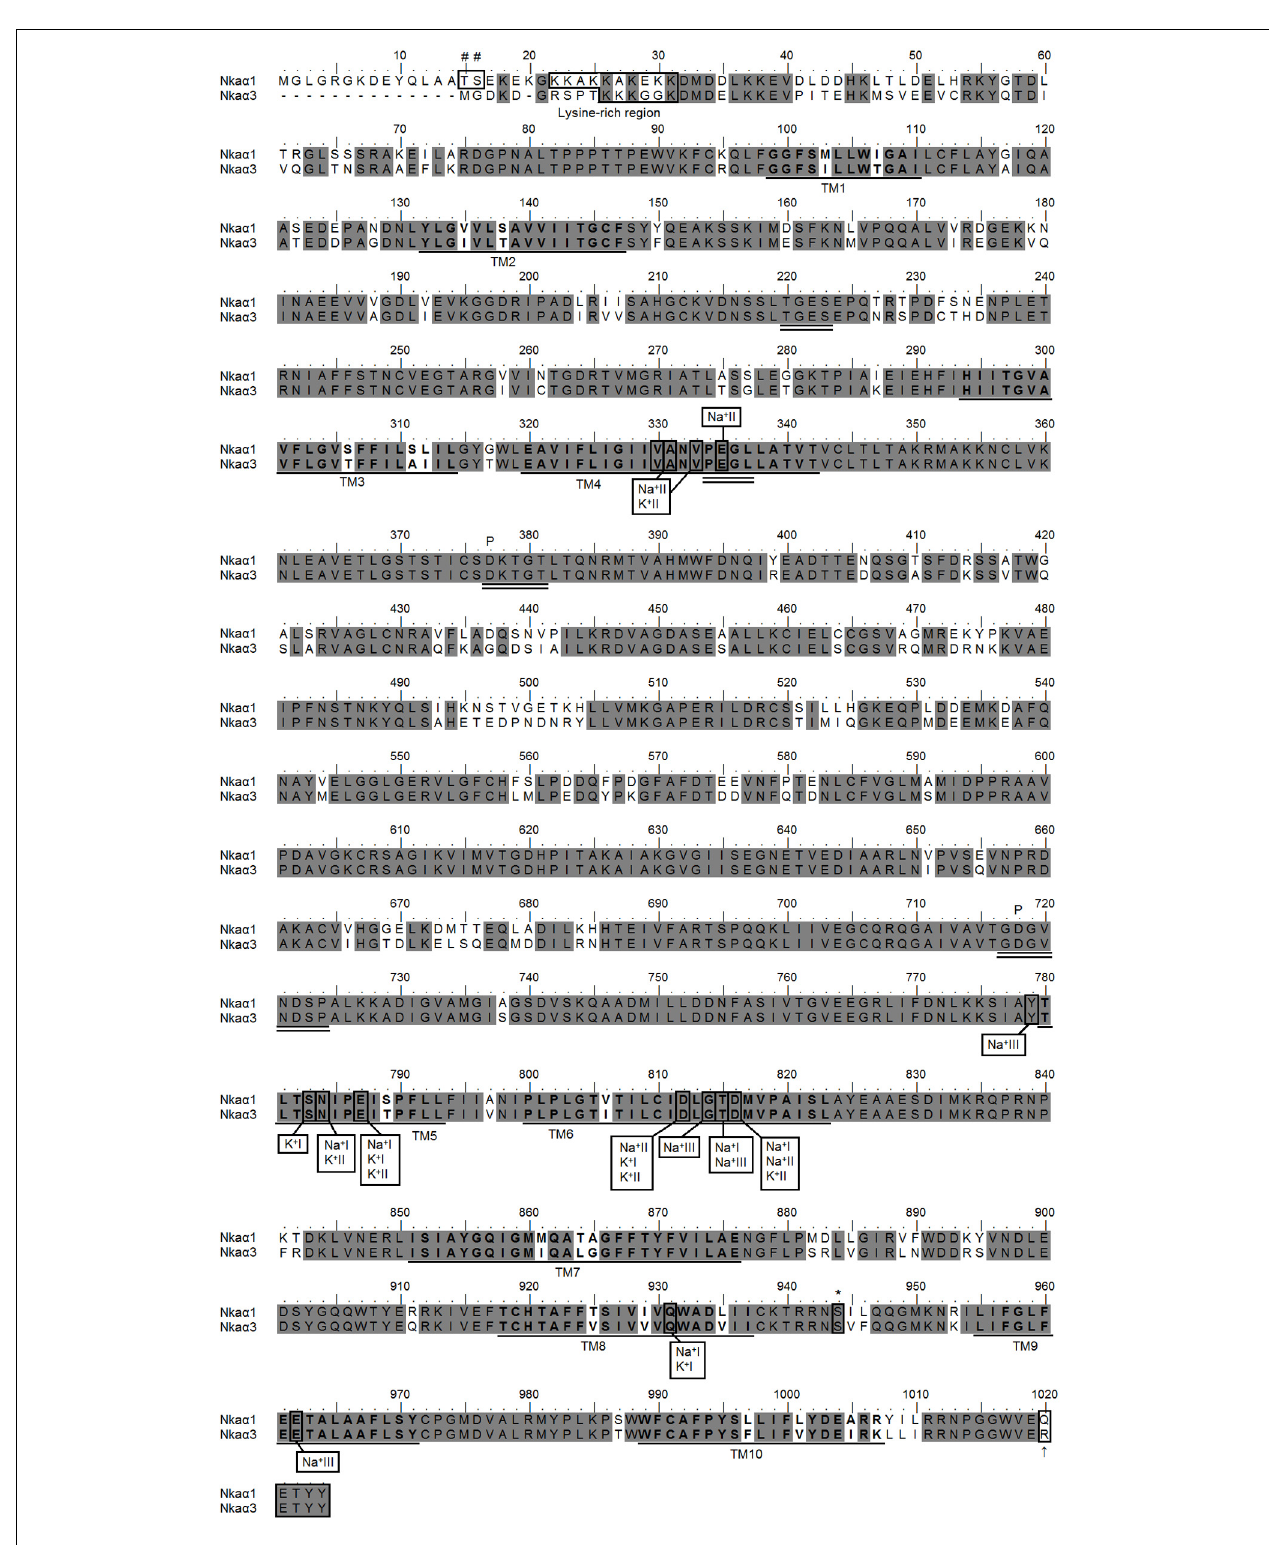
FIGURE 4 | Molecular characterization of Na + /K + -ATPase (Nka) α 1 and Nka α 3. Amino acid sequence alignment of Nka α 1 and Nka α 3 from the gills of Periophthalmodon schlosseri . Identical amino acid residues are indicated by